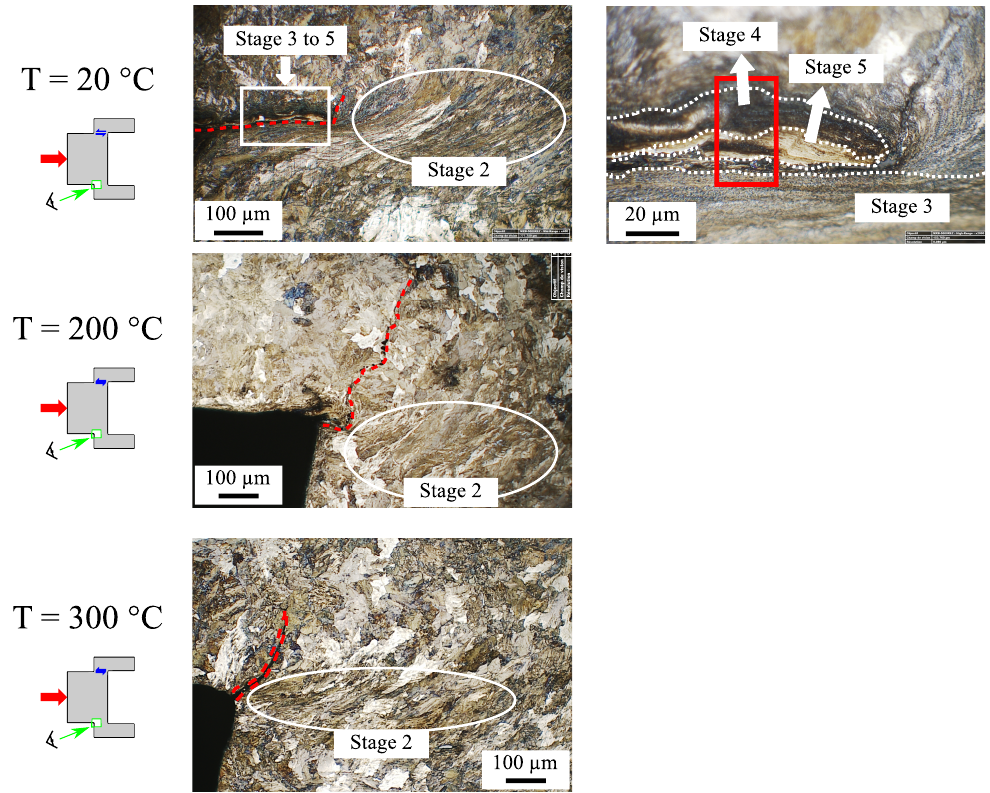
Figure 10. Effect of temperature on the microstructural gradient in the sheared zone of the specimen at the end of the cyclic tests. The mechanical loading and the number of cycles at each temperature are shown in Table 6. The red dotted line denotes the start of cracking in the corner of the specimen. The red box corresponds to the area investigated by EBSD in Figure